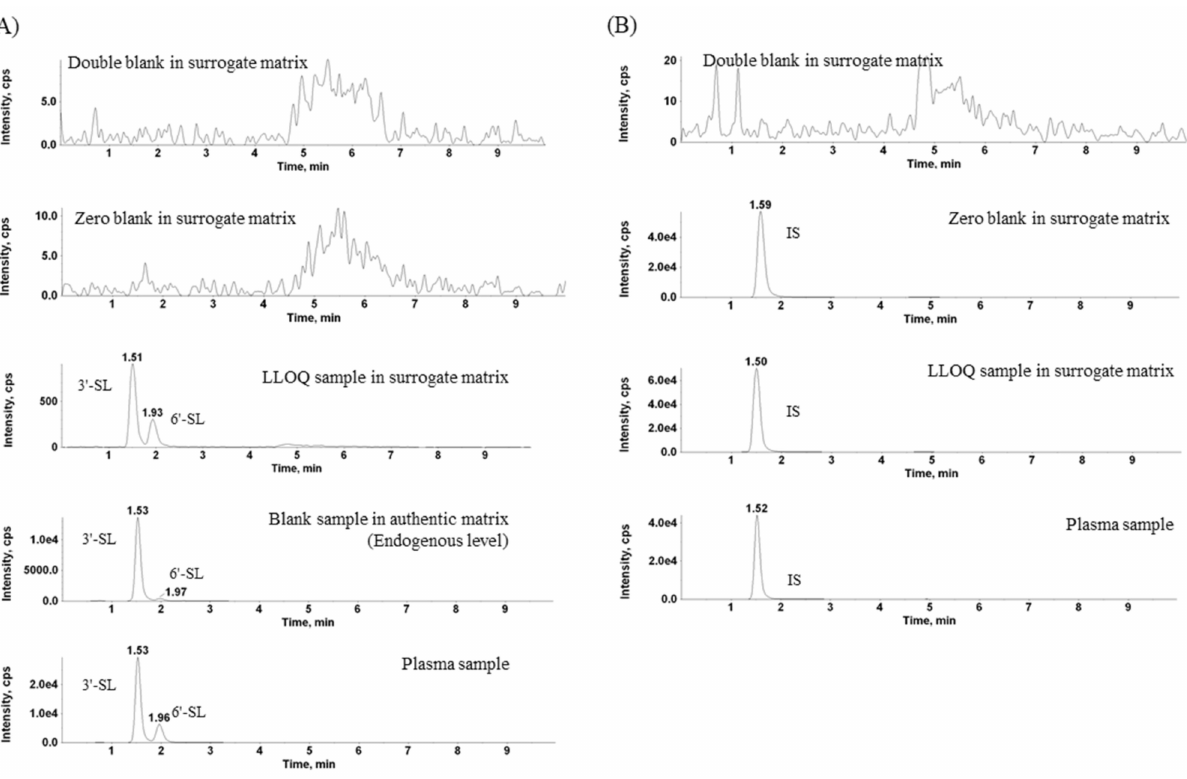
Figure 1. Extracted multiple-reaction monitoring (MRM) chromatograms at ( A ) m/z 632.4 → 290.0 for 3 (cid:48) -SL (sialyllactose) and 6 (cid:48) -SL; double blank, zero blank, and lower limit of quantification (LLOQ) in the surrogate matrix, blank sample in authentic matrix, and rat plasma sample and ( B ) m / z 636.2 → 293.0 for internal standard; double blank, zero blank, and LLOQ sample in the surrogate matrix, and rat plasma